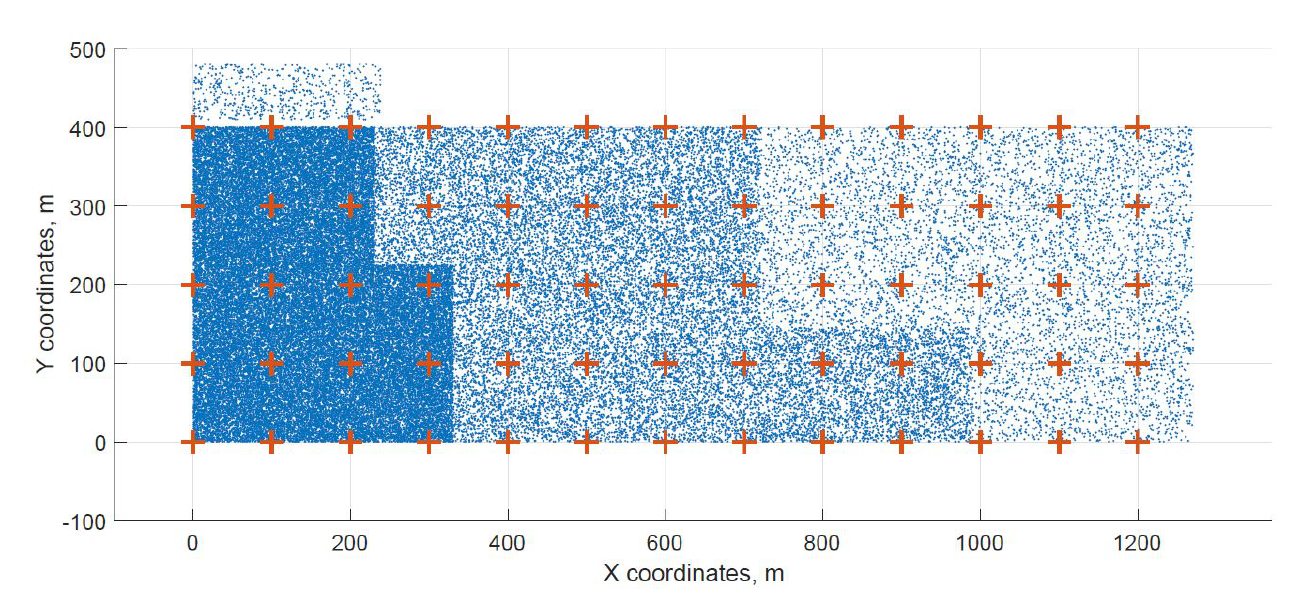
Figure 3. Original distribution grid with FBSs placed inside of the area for dataset